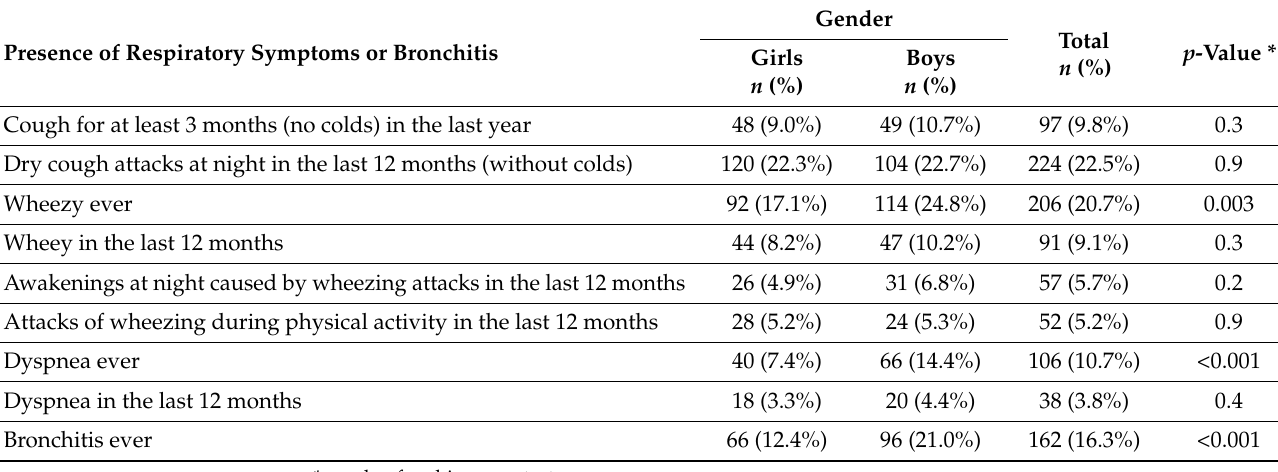
Table 2. Presence of respiratory symptoms or bronchitis versus gender.